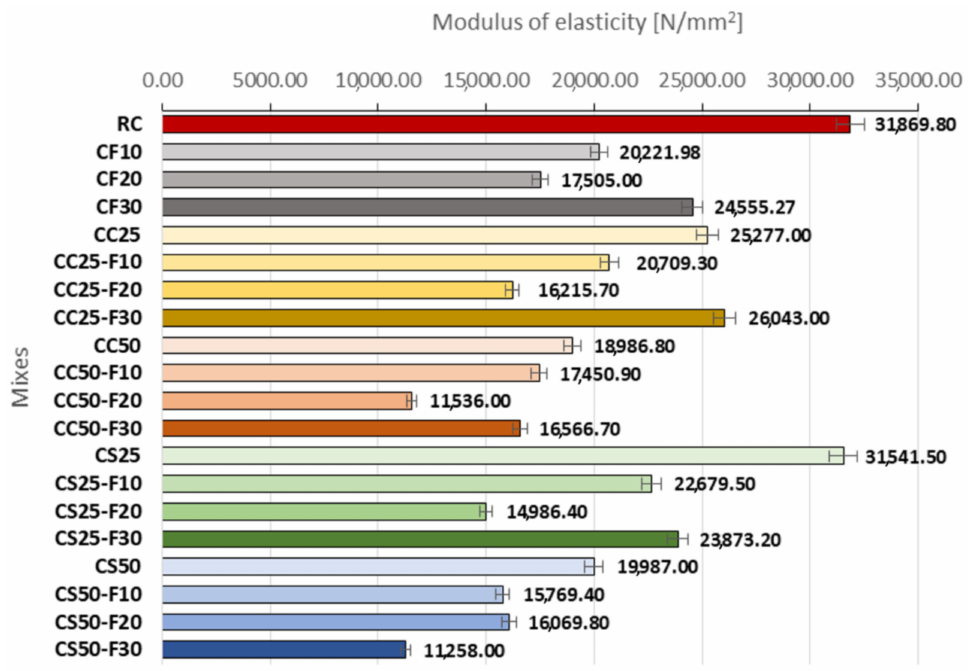
Figure 21. The modulus of elasticity of composite